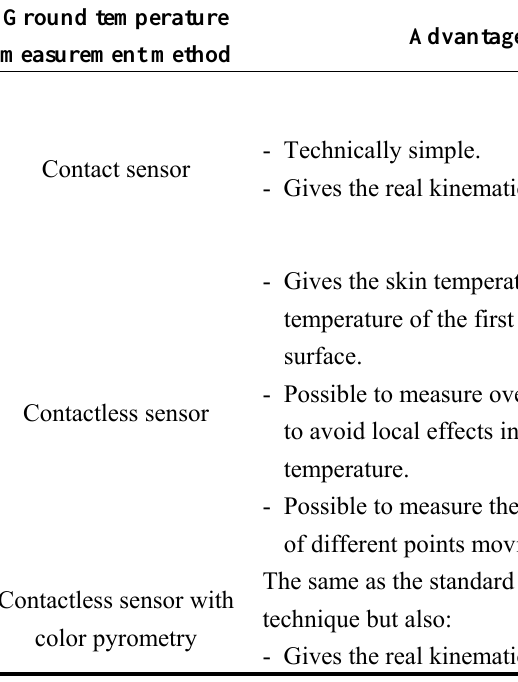
Table 1. General methods to measure ground temperatures.